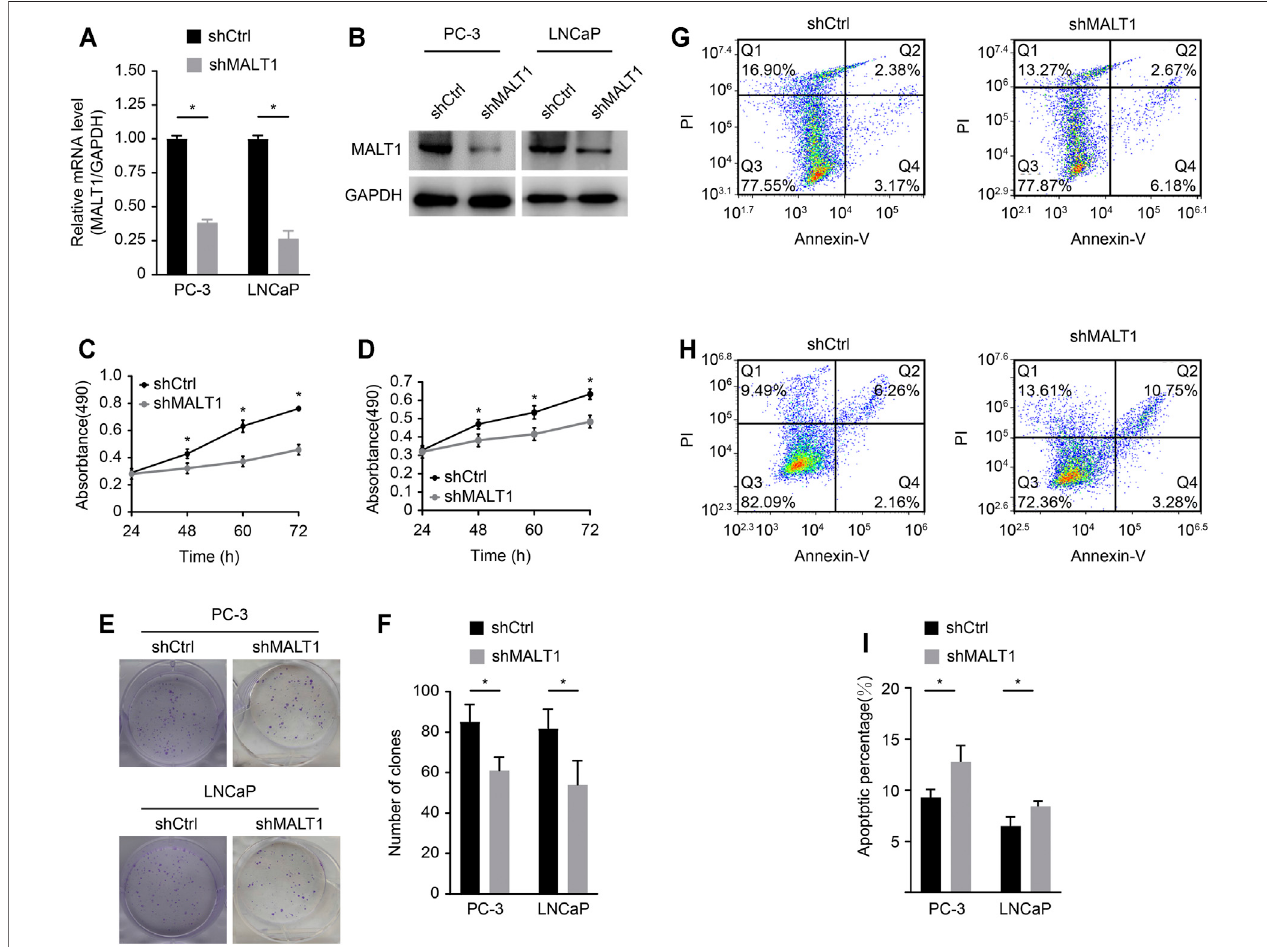
FIGURE 2 | Role of MALT1 in the growth and survival of prostate cancer cells. (A) qRT-PCR results showing signi fi cantly reduced mRNA expression levels of MALT1vsGAPDHinMALT1KDcells. (B) WesternblotshowingreducedMALT1proteinexpressioninMALT1KDcells. (C) GrowthcurvesofPC-3cellsand (D) LNCaP cells measured by MTT assay. (E, F) Comparison of colony-forming ability between control and MALT1 KD cells. (G) The apoptosis ability of LNCaP cells and (H) PC-3 cellswasdetectedby fl owcytometry.Cellsweredividedintofourquadrants:Q1:AnnexinV-FITC-/PI+,whichwasrepresentativeofmechanicalerror;Q2:Annexin V-FITC+/PI+, which was representative of late apoptotic or necrotic cells; Q3: Annexin V-FITC -/PI-, which was representative of living cells; and Q4: Annexin V- FITC+/ PI-, which was representative of early apoptotic cells. (I) Statistic analysis of (G , H)